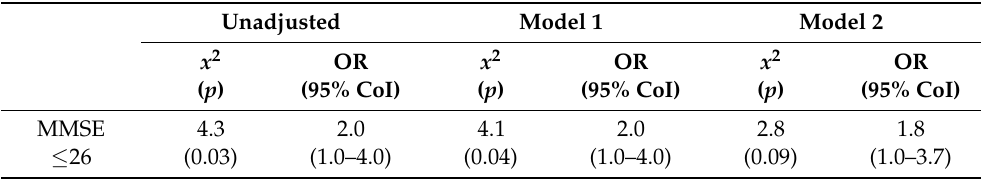
Table 8. Odds of MMSE scores indicative of MCI by KCNJ2 -A allele presence in the total cohort, in unadjusted and adjusted models.